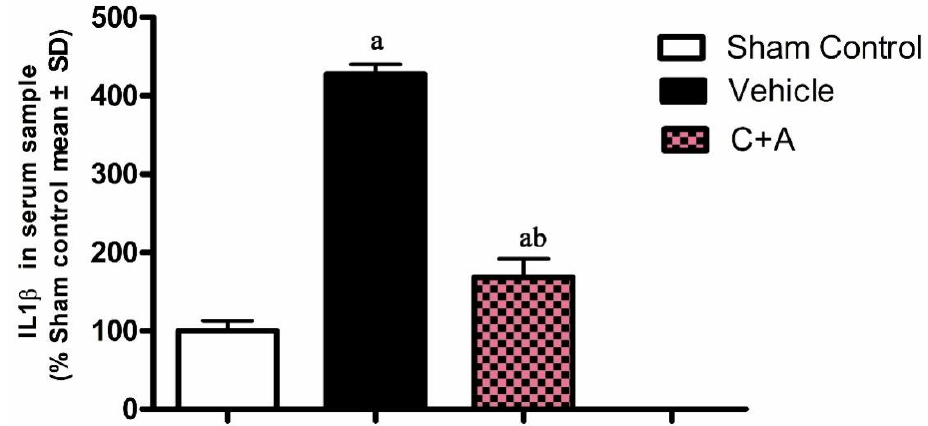
Figure 4. ELISA results showed that treatment with C16 plus Ang-1 decreased the serum level of pro-inflammatory factor IL-1 β . a, p < 0.05 vs. sham control group; b, p < 0.05 vs. vehicle group.